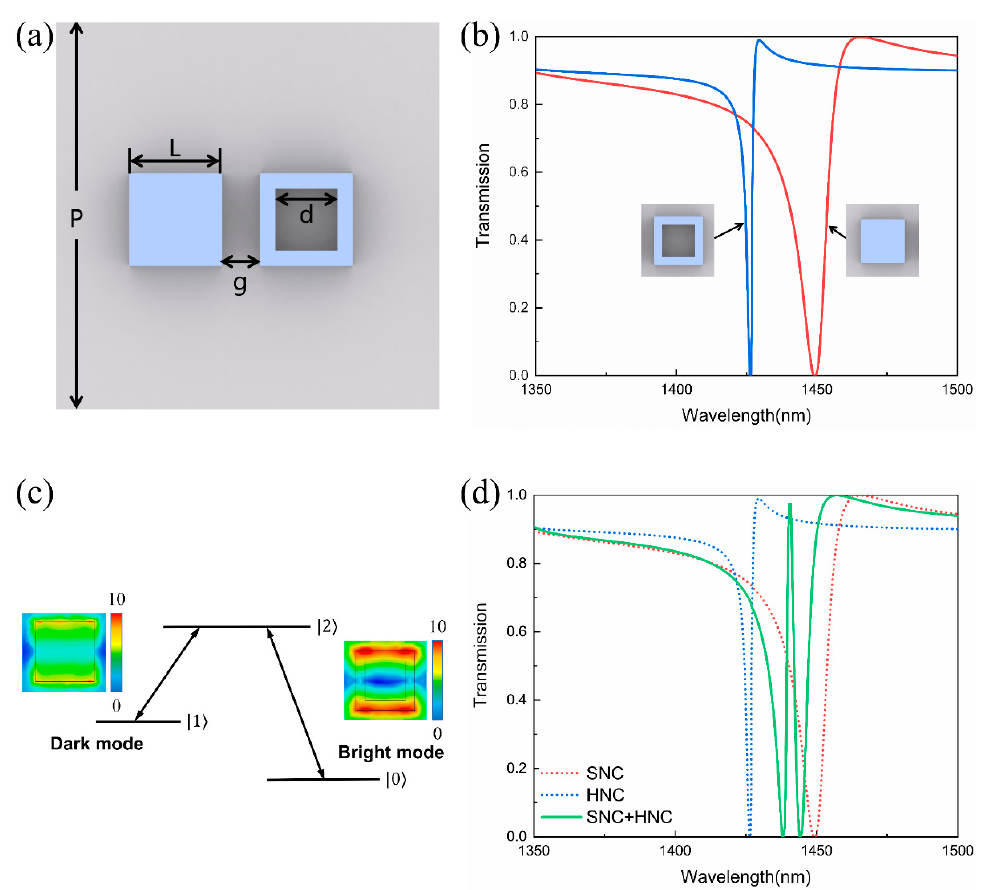
Figure 3. ( a ) Geometric parameters of the dielectric metamaterial without graphene: P = 1500 nm, L = 364 nm, d = 244 nm, g = 150 nm. ( b ) The simulated transmission spectra of the separate SNC and HNC. ( c ) Schematic of interference between the bright- and dark-mode resonators. Inset: Electric field distribution of the bright and dark modes at resonant wavelength. ( d ) The simulated transmission spectra of the proposed metamaterial.